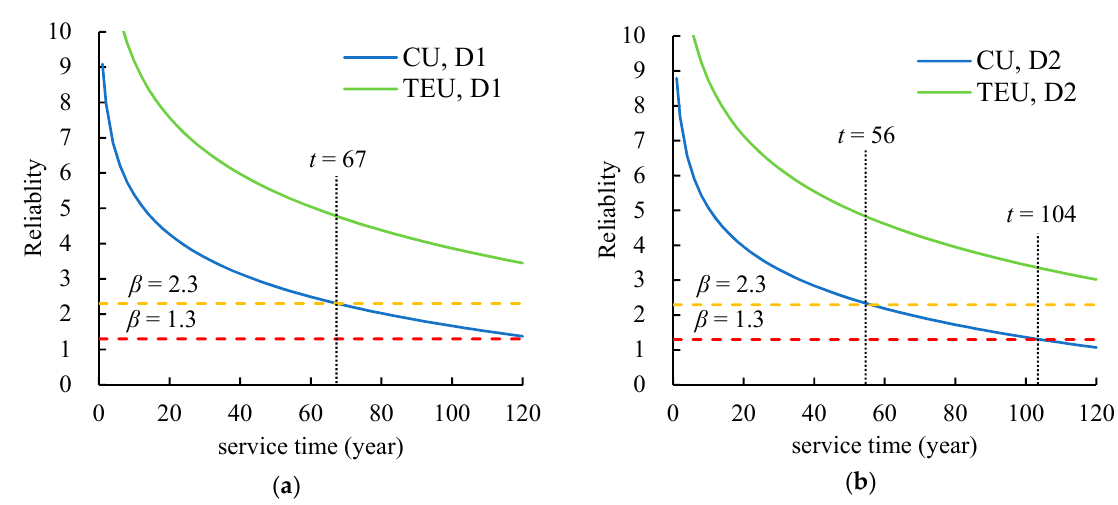
Figure 16. Reliability in terms of nominal stress: ( a ) critical detail D1 and ( b ) critical detail D2.